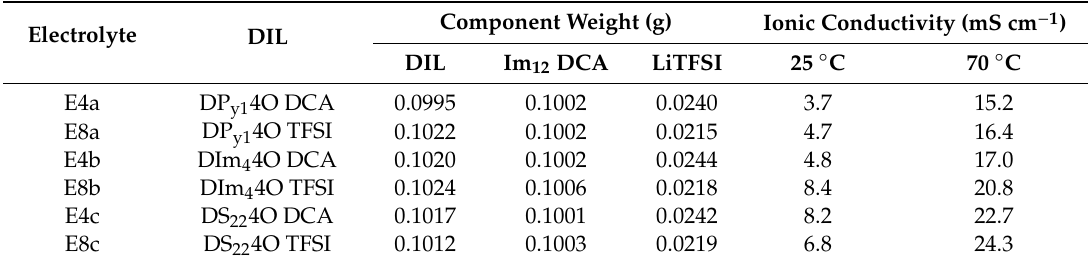
(Table 7). Two electrolyte formulations that passed the minimum ionic conductivity threshold are DIm 44O TFSI and DS 224O DCA. Table 7. Properties of DIL-based formulated electrolytes containing 0.5 M LiTFSI [54]. Electrolyte DIL